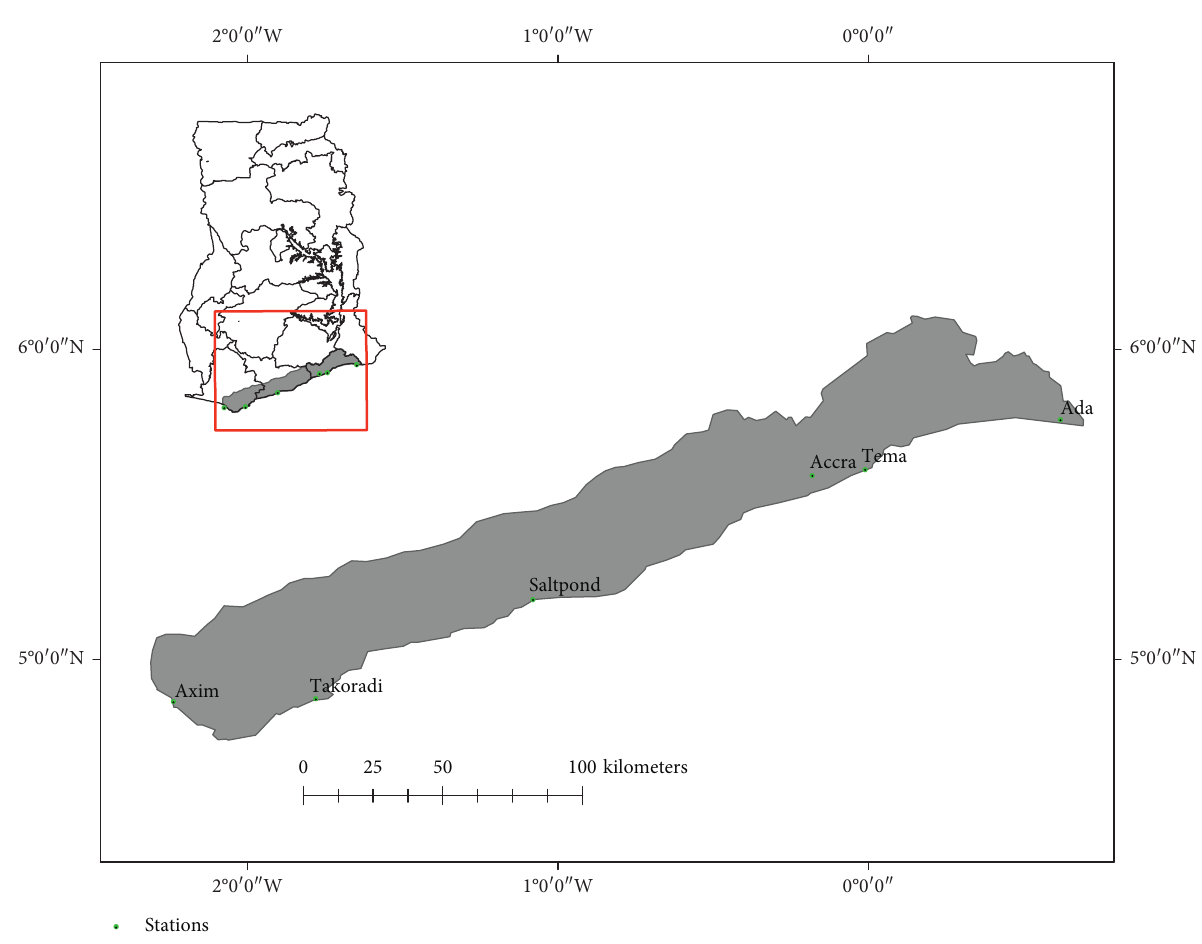
Figure 1: Study area highlighted from the map of Ghana with the six synoptic meteorological stations of Coastal